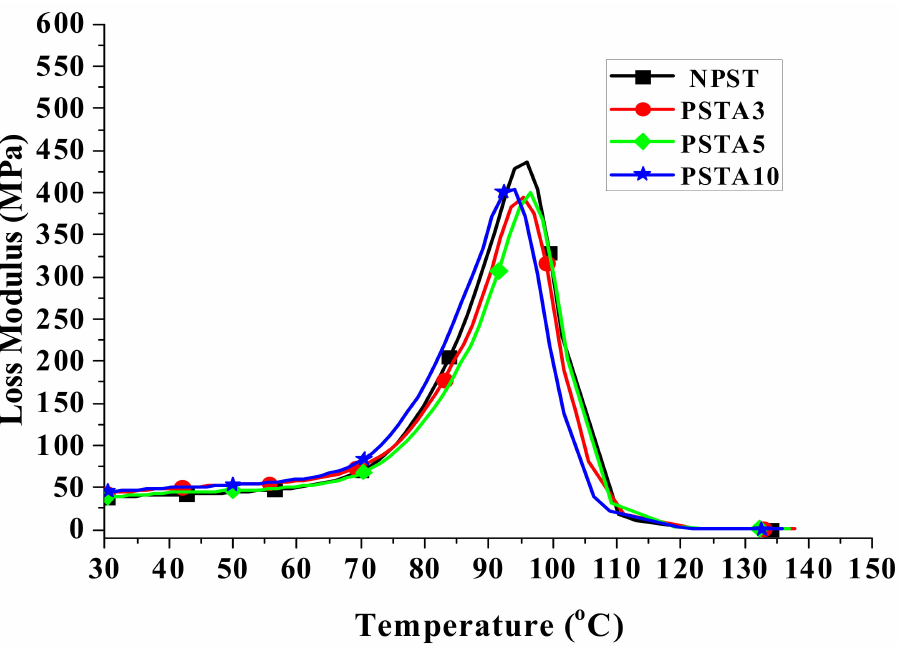
Figure 8. The measured loss moduli of Type II samples with respect to the temperature changes.